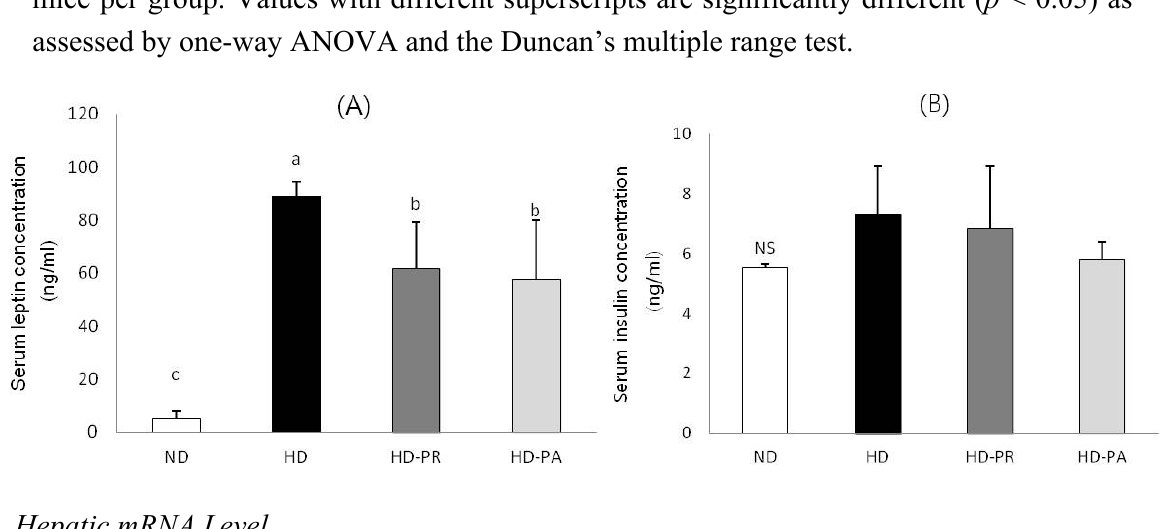
Figure 1. ( A ) Serum leptin and ( B ) insulin levels. Bars represent the mean ± SEM, n =